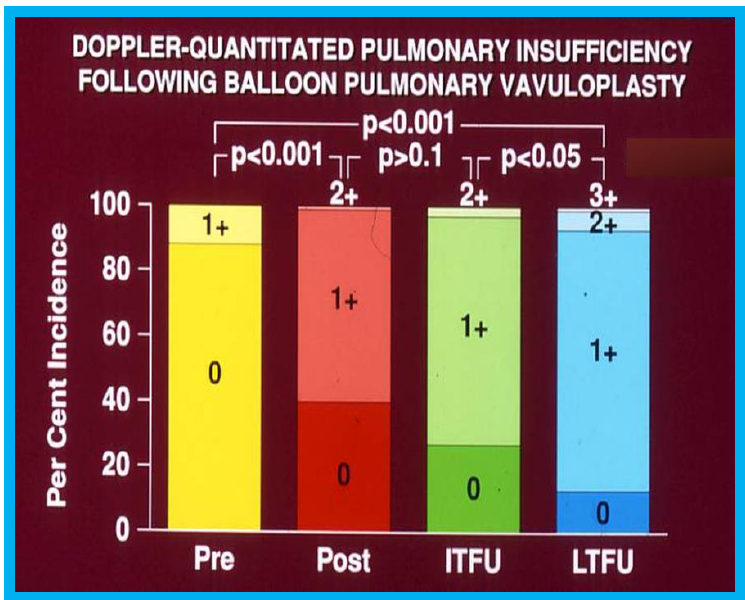
Figure 15. Bar graph showing Doppler-graded pulmonary insufficiency prior to (Pre) and one day after (Post) balloon pulmonary valvuloplasty and at intermediate-term (ITFU) and long-term (LTFU) follow-up: A gradual but significant increase ( p < 0.05 to p < 0.001) in the incidence of pulmonary insufficiency is seen. Reproduced from Rao P.S., et al. [16].